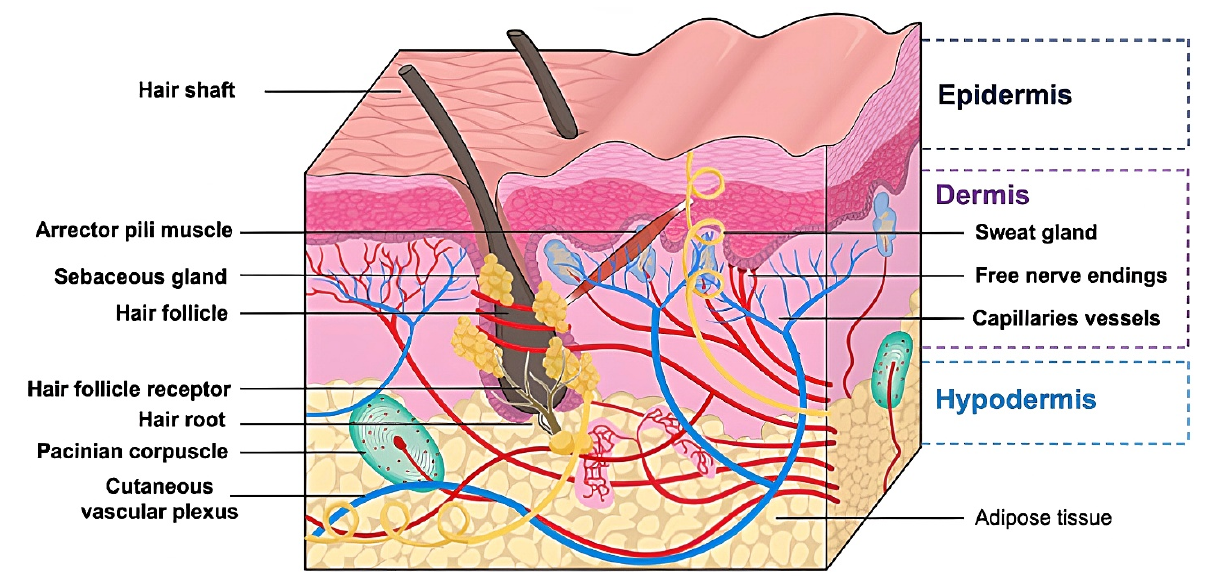
Figure 1. Schematic representation of human skin layers. Image reprinted with permission from [8].